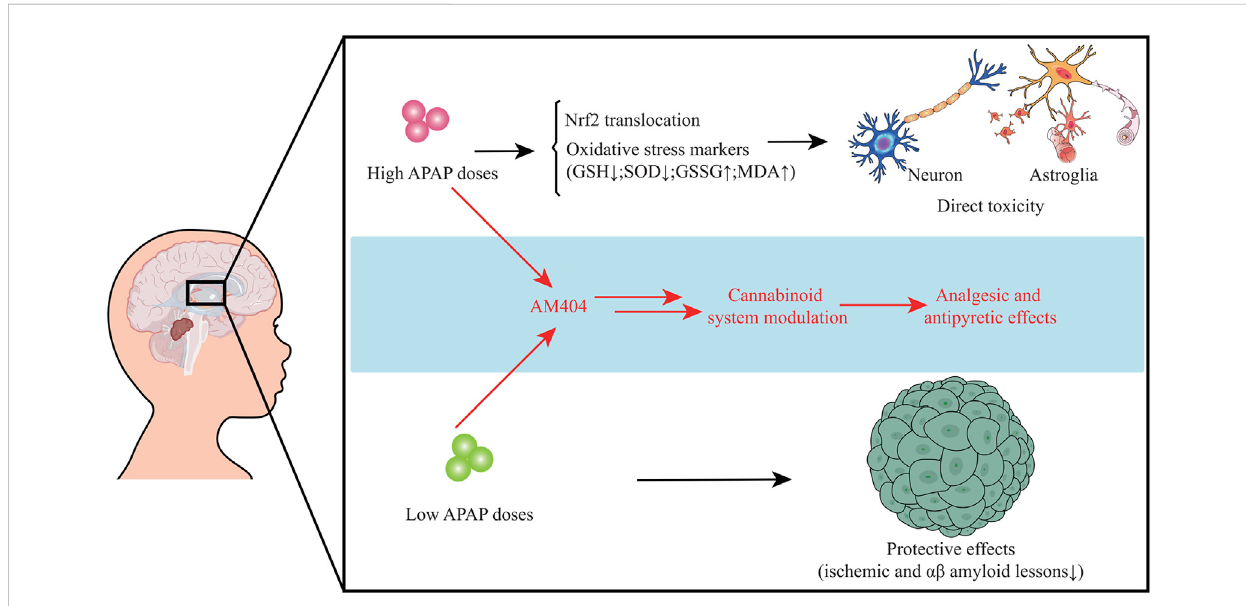
FIGURE 1 High dose of APAP may induce oxidative stress and affect Nrf2 function resulting in reduction of oxidative stability and increment of toxic response to cause direct toxicity to neuron and astroglia. However, low dose of APAP may mediate neuroprotective actions. Low and high APAP doses can exert analgesic and antipyretic actions through regulation of cannabinoid